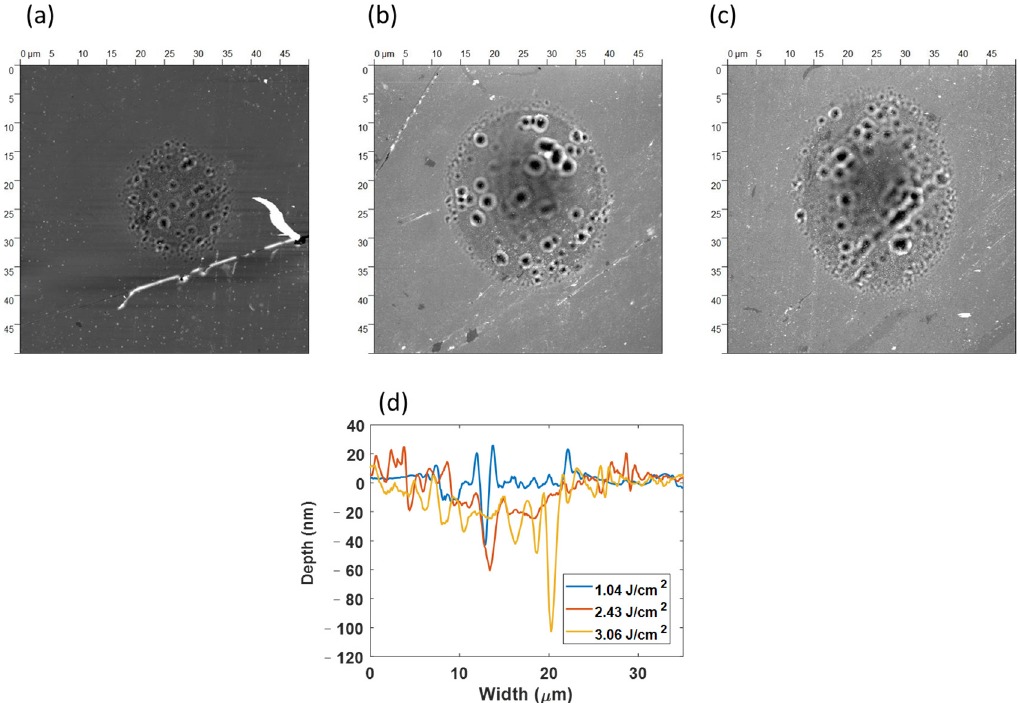
Figure 2. (a)-(c) are the AFM images obtained by di ff erent fl uences: ( a ) 1.04 J/cm 2 , ( b ) 2.43 J/cm 2 , and Figure 2. ( a – c ) are the AFM images obtained by different fluences: ( a ) 1.04 J/cm 2 , ( b ) 2.43 J/cm 2 , and ( c ) 3.06 J/cm 2 and ( d ) is the AFM pro fi le obtained by these fl uences. ( c ) 3.06 J/cm 2 and ( d ) is the AFM profile obtained by these